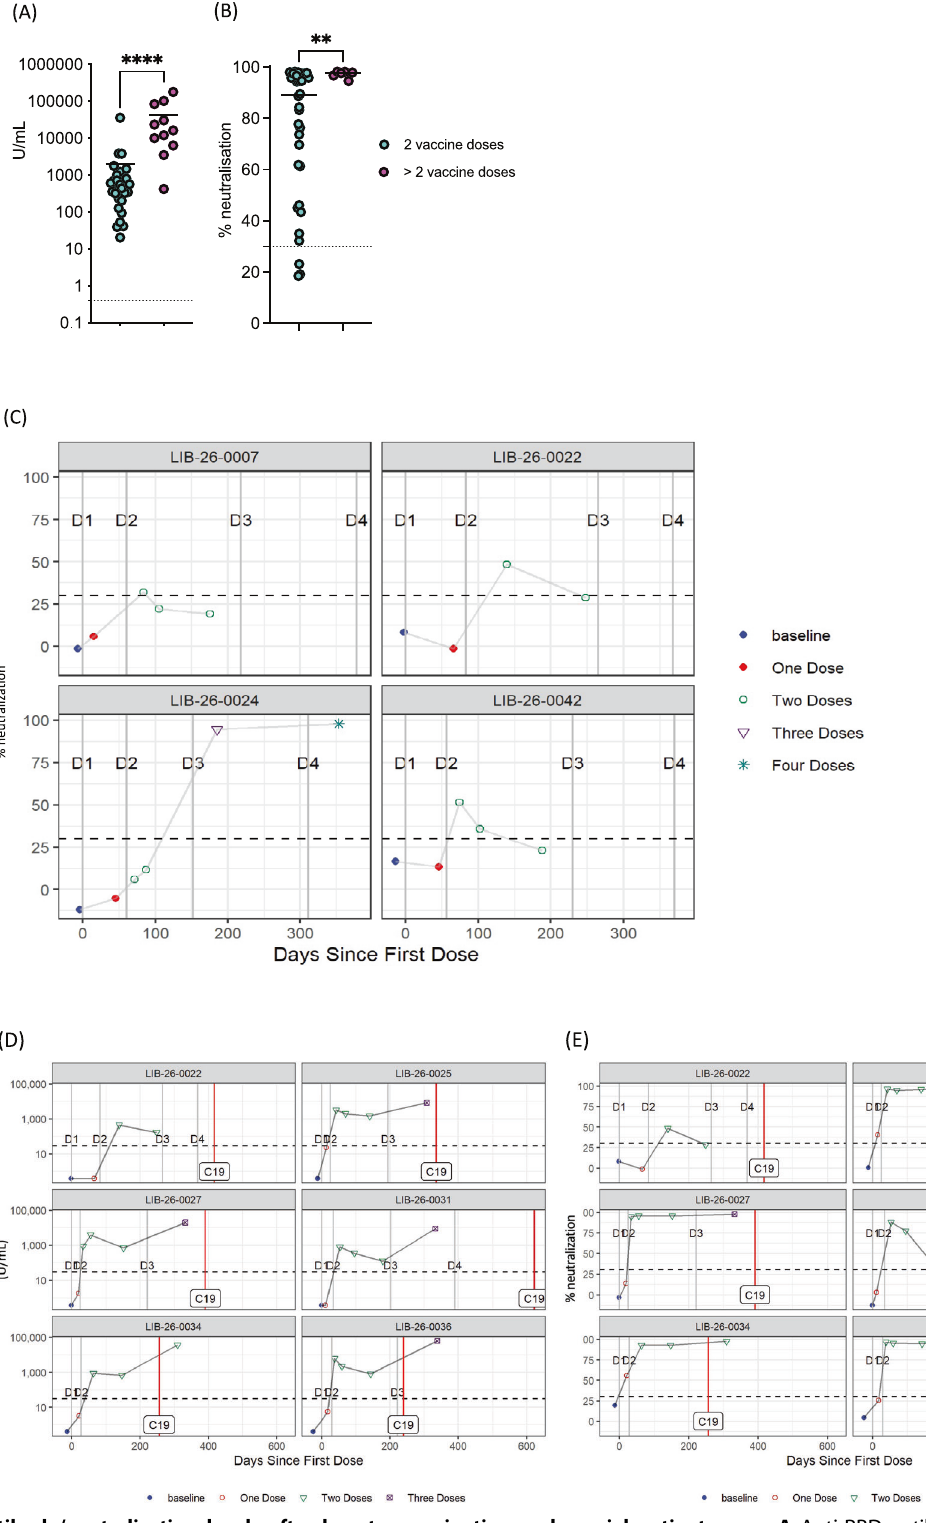
Fig. 2 Antibody/neutralization levels after booster vaccination and special patient cases. A Anti-RBD antibody levels between patients received 2 vaccine doses (cyan, n = 29) versus patients received >2 vaccine doses (magenta, n = 11) at 4 – 6months following completion of initial vaccination series (2 doses). B Neutralizing antibody levels between patients received 2 vaccine doses (cyan, n = 34) versus patients received >2 vaccine doses (magenta, n = 6) at 4 – 6months following completion of initial vaccination series (2 doses). C Neutralizing antibody levels in patients with low neutralization in relation to time and administration of vaccination doses (D1: 1st dose, D2: 2nd dose, D3: 3rd dose and D4: 4th dose). D Anti-RBD antibody levels in patients who contracted SARS-CoV-2 in relation to vaccination doses and SARS-CoV-2 infection (shown as red line labelled C19). E Neutralizing antibody levels in patients who contracted SARS-CoV-2 in relation to vaccination doses and SARS-CoV-2 infection (shown as red line labelled C19). A , B Mann – Whitney test used for comparison between groups. (**** p <0.0001; ** p < 0.01;). Cell Death and Disease (2023)